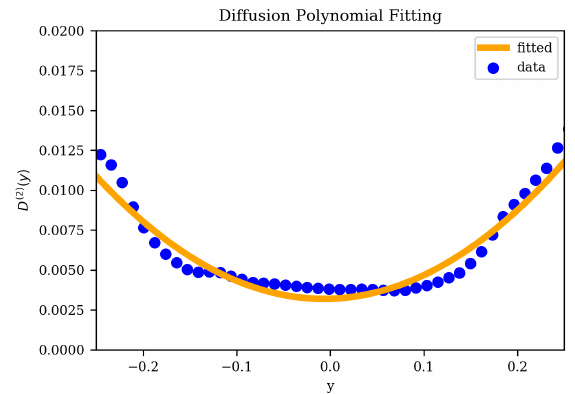
Figure 6. Diffusion parameter fitted to a second-order polynomial.